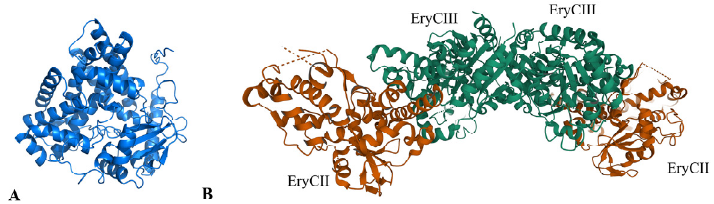
Figure 7. Structure information of AknT. ( A ) Predicted structure model of AknT; ( B ) The cartoon image of ErycIII in complex of EryCII.